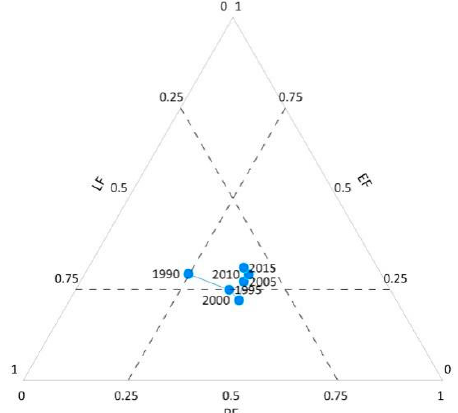
Figure 6. The stage and trend of the production-living-ecology land use multifunctionality in the Beijing-Tianjin-Hebei region (1990–2015).